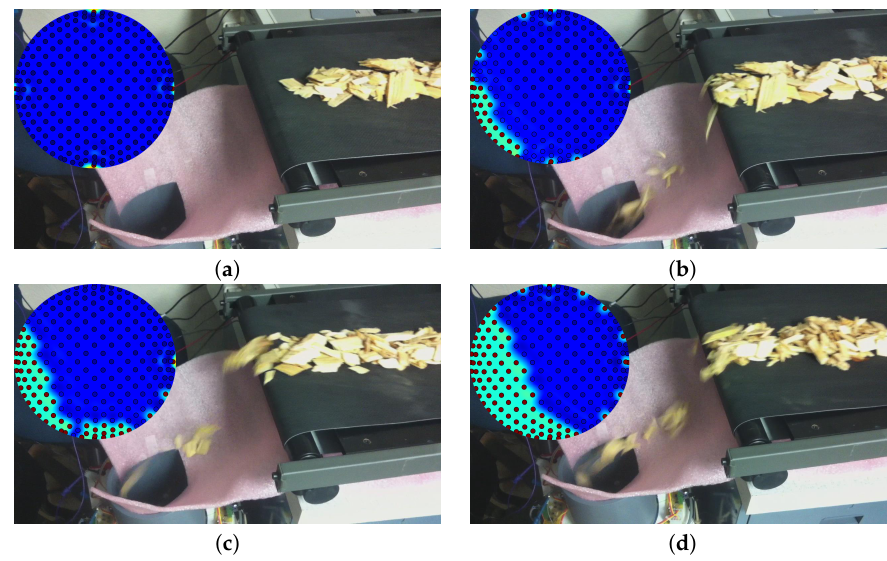
Figure 2. Images of the sensor chip feeding process used in a typical experiment, along with an accompanying image of permittivity distribution. Chips were moved on the conveyor belt and dropped into the sensor opening below the red fabric that was used to capture material falling short. ( a ) illustrated the situation when the sensor was empty; ( b – d ) were with increasing quantities of wood chips present in the enclosure. The colored images were interpolated from the estimated G matrix using the matplotlib.interpolate function with radial basis